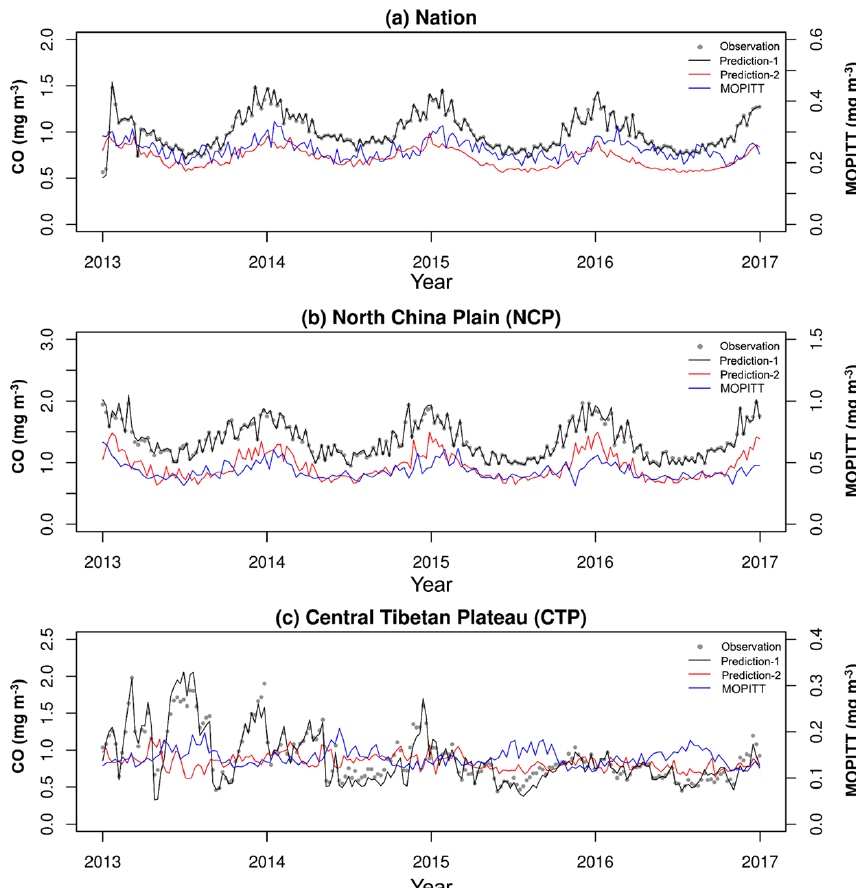
Figure 4. Temporal variations of the average ground-level CO concentrations for (a) the whole nation, (b) the North China Plain (NCP), and (c) the central Tibetan Plateau (CTP) during 2013–2016 based on the observations from the monitoring network (gray points), the RF–STK predictions (black and red solid lines), and the MOPITT retrievals (blue solid lines). The black lines show the RF–STK predictions for the grid cells with monitoring sites (prediction-1), and the red lines show the RF–STK predictions for all the grid cells (prediction-2). Weekly averages rather than daily concentrations are presented for clarity. Please refer to the right y axis for the MOPITT retrievals and the left y axis for all the other time